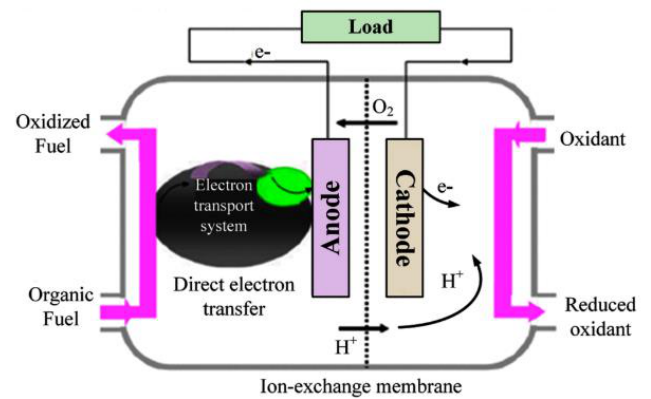
Figure 71. Electricity generation from organic wastes by microbial fuel cell (MFC); at the anode, microorganisms get oxidized and produce CO2 and donates electrons, which travel to the cathode via an external circuit, then recombine with oxygen to produce water